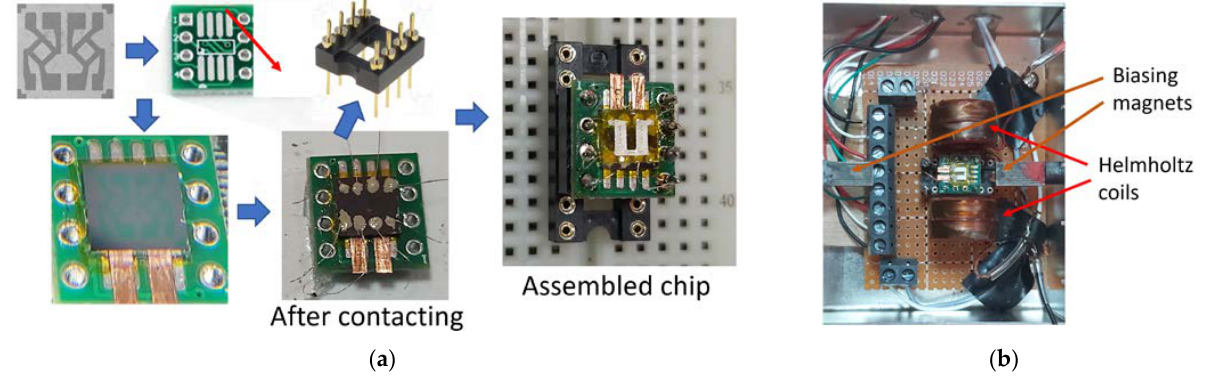
Figure 13. Demonstrator setup: ( a ) Steps for assembling the demonstrator chip; ( b ) The sensor mounted in the shielded box, as implemented for characterization and testing.